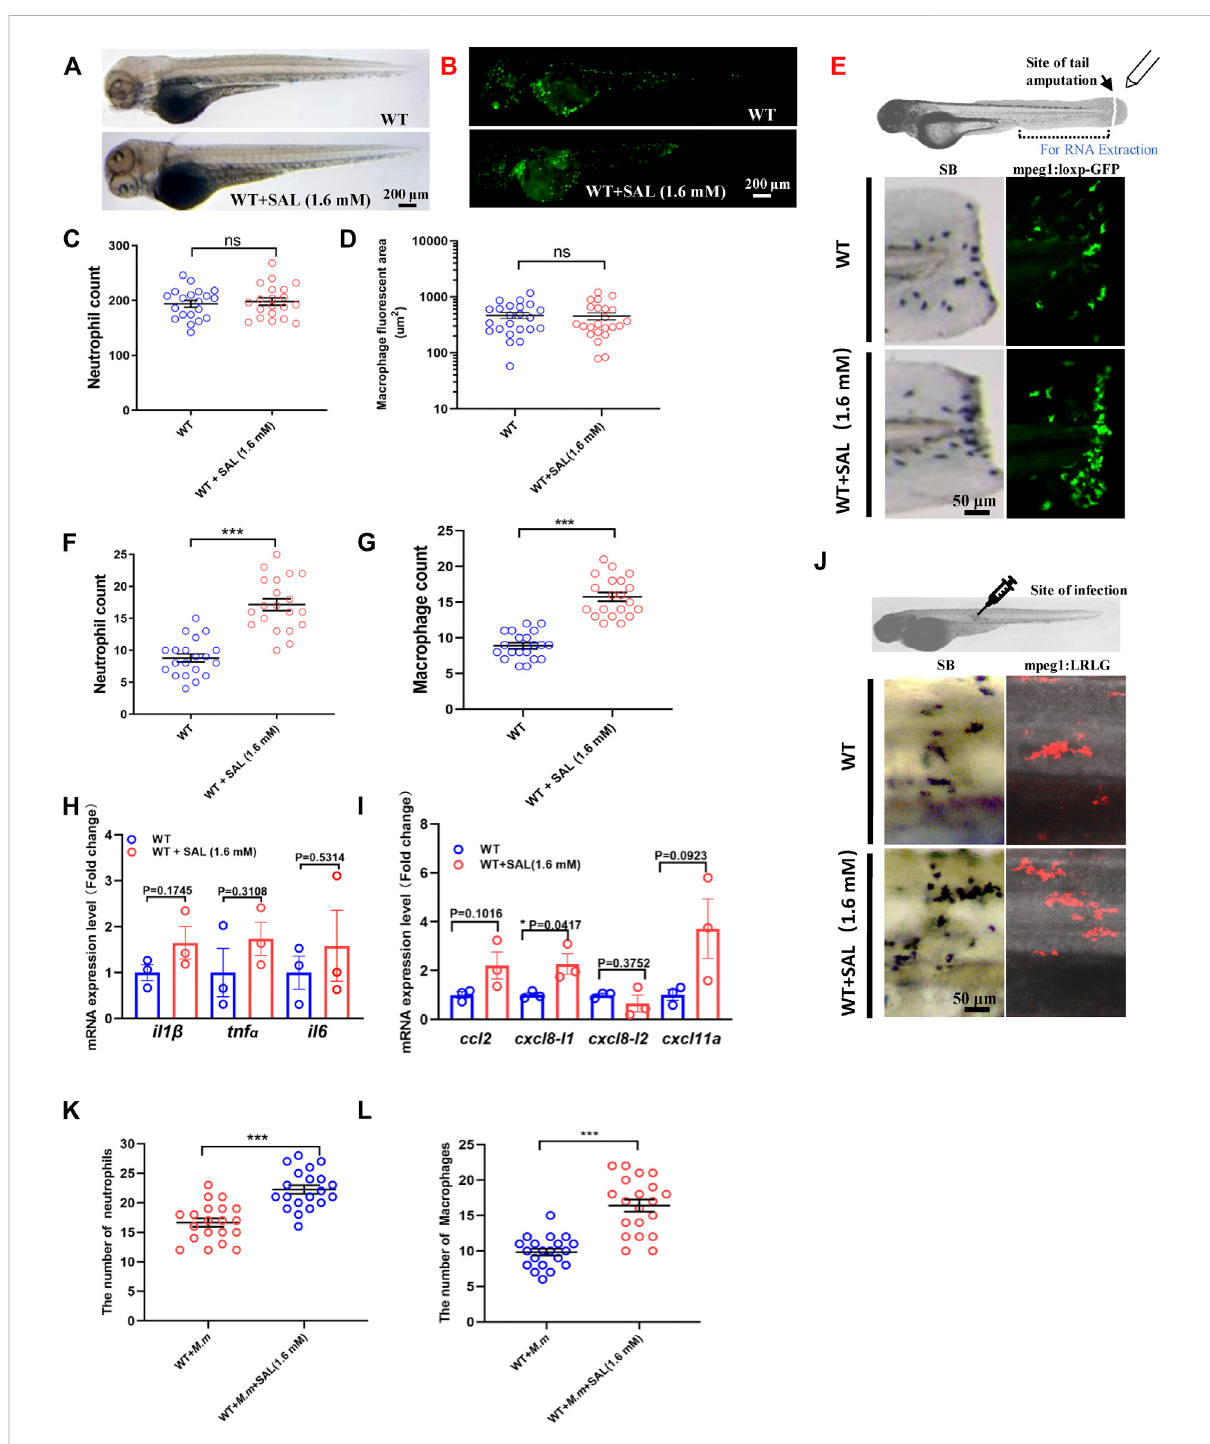
FIGURE 3 SALpromotestherecruitmentofinnate immunecells tothewoundandinfection sites. (A) ImagesofwholebodySBstainingof3-dpfembryos. (B) Fluorescent images of 3-dpf Tg (mpeg1:loxP-GFP) embryos. A and B Scale bar: 200 μ m. (C) Statistics of the number of SB + neutrophils in A. (D) Quanti fi cation of total macrophage fl uorescent area in B. (E) Schematic view of tail amputation experiment and the tissue for RNA extraction (upper panel); therecruitmentof SB + neutrophils to wound (left panel); and therecruitmentof mpeg1:loxp:GFP + macrophagesto wound (right panel). Scale bar: 50 μ m. (F) Statistics of the number of SB + neutrophils in E. (G) Statistics of the number of macrophages in E. (H) Expression of various cytokines in the tail region at 2 hpa. (I) Expression of macrophage and neutrophil recruitment-related chemokines in the tail region at 2 hpa. (J) Images of theSB + neutrophils (left panel) and mpeg1:LRLG + macrophages (right panel) in fi ltration to infection sites. Scale bar:50 μ m. (K) Statisticsof the number of SB + neutrophils in J. (L) Statistics of the number of macrophages in J. A – G, J – L: n = 20 per group; H and I: n = 30 per sample. This is one representative data from three independent biological